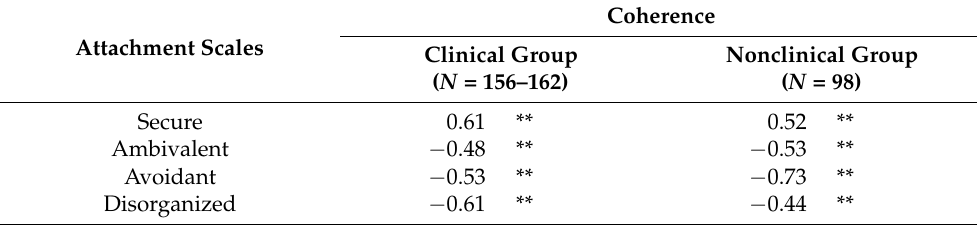
Table 8. Correlations between the four Attachment Scales and Coherence. Coherence Attachment Scales Clinical Group Nonclinical Group ( N = 156–162) ( N = 98) Secure 0.61 ** 0.52 Ambivalent − 0.48 Avoidant −